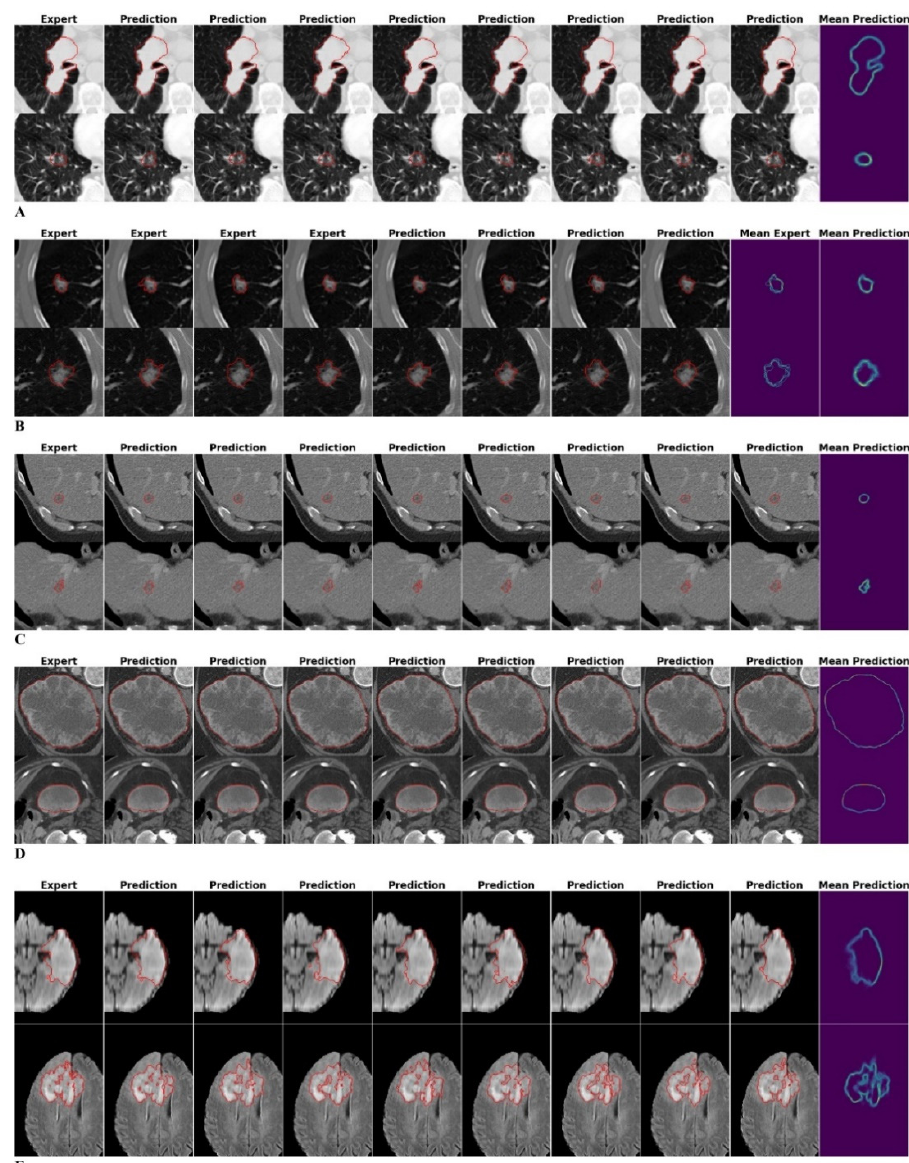
Figure 2. Manual expert and automatic-generative neural network-based segmentation outlines of representative lesions of the NSCLC (Non-Small Cell Lung Cancer) ( A ), LIDC (Lung Image Database Consortium) ( B ), LITS (Liver Tumor Segmentation) ( C ), KITS (Kidney Tumor Segmentation) ( D ), and BRATS (Brain Tumor Segmentation) ( E ) datasets. The rightmost column shows an overlay of all available segmentation outlines. Only the LIDC dataset provides four different manual segmentation outlines (by experts) per lesion whose overlay is shown as the additional column titled “Mean Expert”. Overall, neural network-based predictions produce realistic and robust segmentation outlines. Variability in automatic-generative segmentation outlines is increased in tumor regions where delineation is inherently difficult.